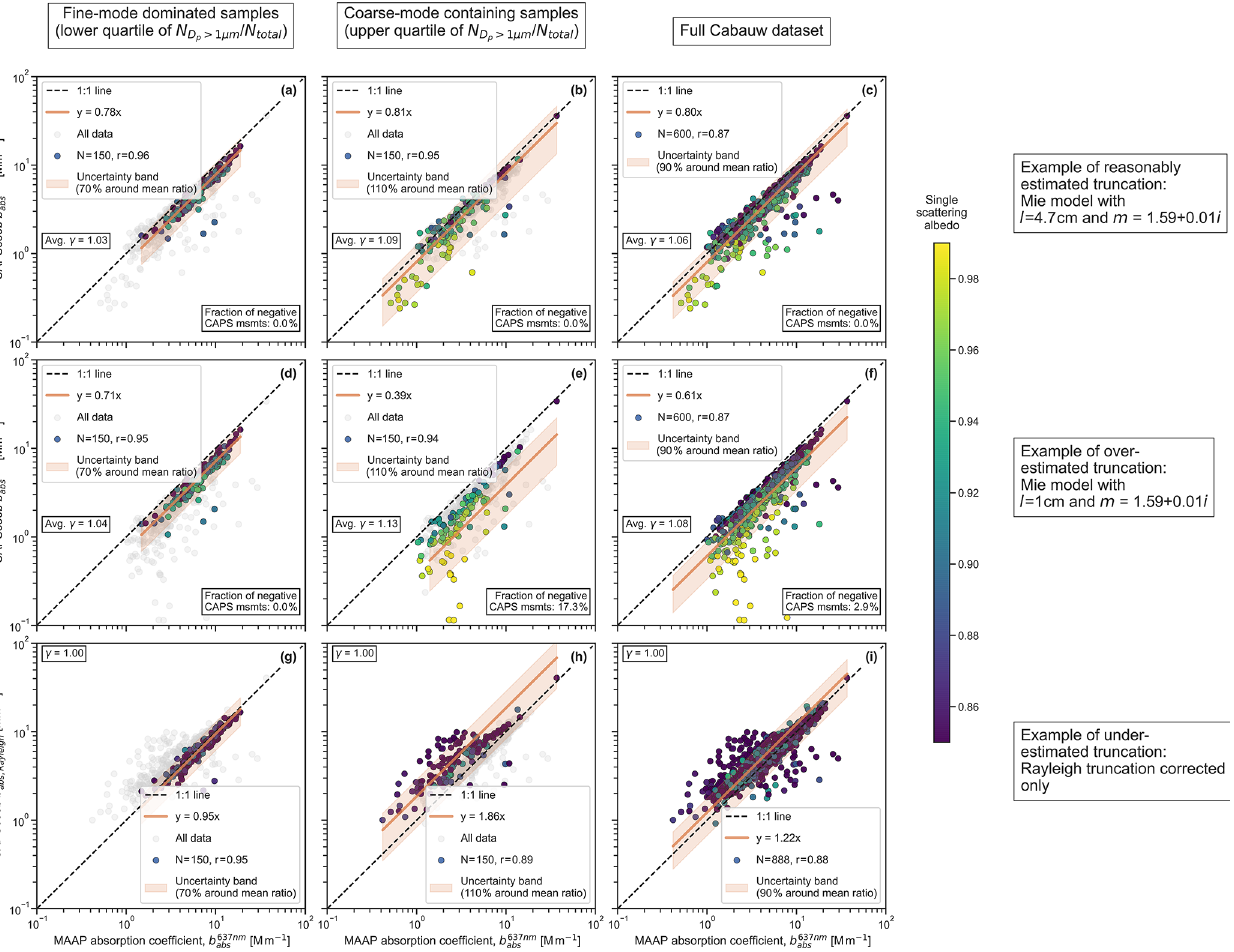
Figure 8. Comparison of CAPS PMssa absorption coefficients at 630nm ( b 630nm ) and MAAP absorption coefficients at 637nm ( b 637nm ) abs abs for three different truncation correction scenarios. The three columns represent different subsets of the dataset, as indicated in the column titles. The three rows represent the different truncation correction scenarios, as indicated in the row labels. Panels (a–c) display CAPS PMssa measurements that were corrected using the Mie-based truncation correction scheme presented in Appendix A with m set to 1 . 59 + 0 . 01 i and l set to 4.7cm. Panels (d–f) display the same type of data with l set to 1cm. Panels (g–i) contain CAPS PMssa measurements corrected for the truncation of Rayleigh scattering only (i.e., γ = 1). All data points are colored by the SSA values calculated from the same CAPS PMssa data shown in each panel. The mean ratios of CAPS PMssa to MAAP b abs are plotted as solid orange lines in each panel. The uncertainty bands represent the 95th percentiles of theoretical uncertainties calculated with the error model and inputs described in Sect. 2.3, with relative uncertainties in γ of 4%, 9%, and 6% for the fine-mode-dominated, coarse-mode-containing, and full datasets, respectively. Uncertainty in MAAP b abs of up to 7% can be expected based on previous studies (Sect. 3.1.1): this uncertainty is not displayed for visual